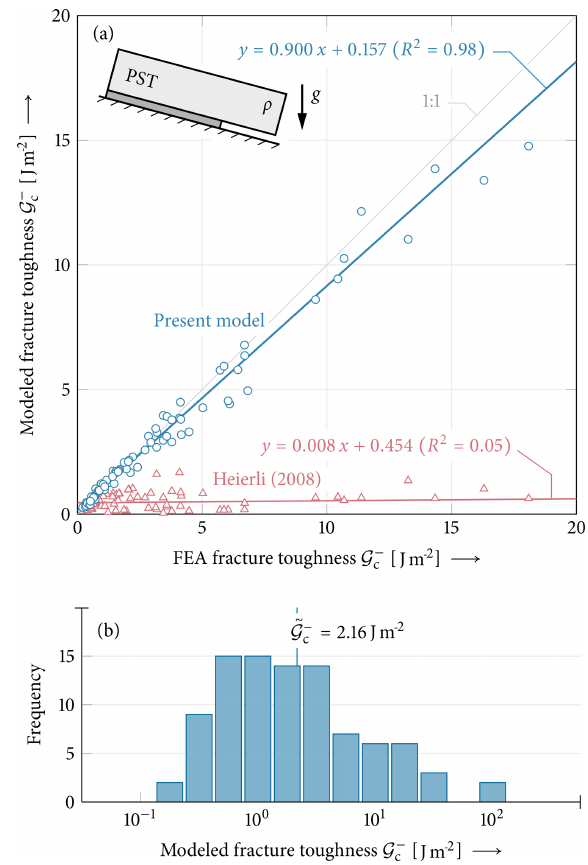
Figure 14. Fracture toughness G − c = G (a c ) determined from 93 field PST experiments reported by Gaume et al. (2017). (a) Com- parison of model and FEA results with corresponding linear regres- sions and coefficients of determination R 2 for the present model (blue) and the model by Heierli (2008) (red). (b) Histogram with logarithmic bin size 10 0 . 25 and median of the 93 fracture tough- nesses calculated using the present model. Data not given in Gaume et al. (2017) are assumed as given in Table